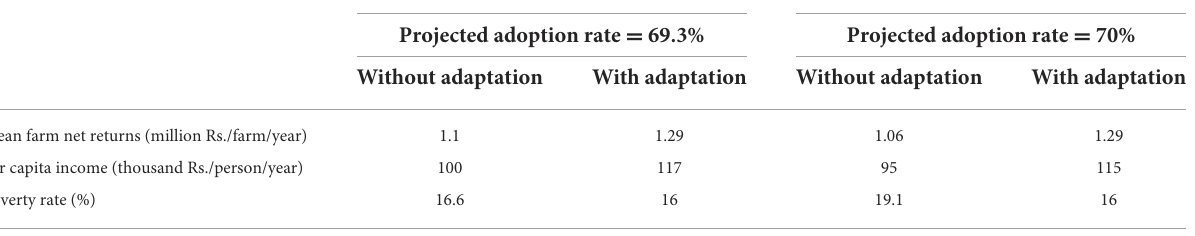
TABLE 6 Projected adoption of adaptation package used in crop models for CCSM4 GCM during mid-century.